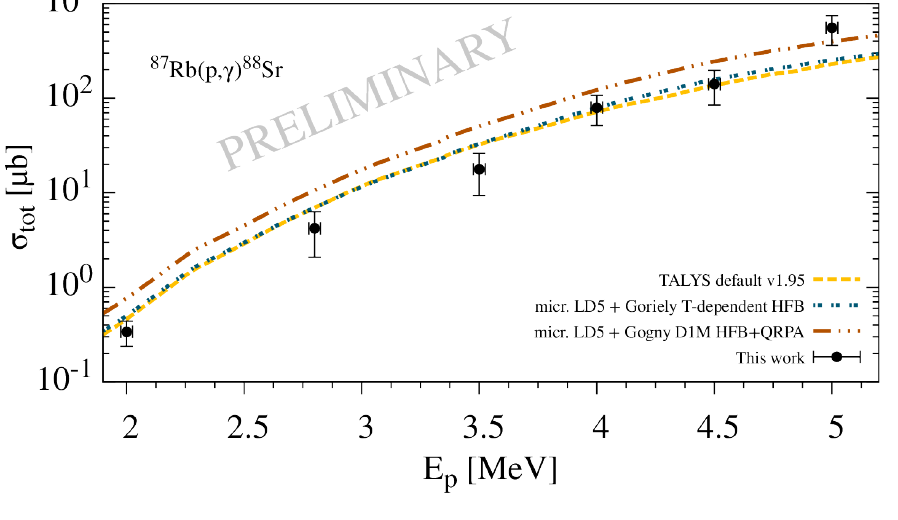
Figure 3. Experimental cross sections for the 87 Rb(p, γ ) 88 Sr reaction obtained in this work (black points). Statistical model calculations using the TALYS 1.95 code [6] are shown. The microscopic level density from Hilaire’s combinatorial tables [7] has been used in combination with the γ -ray strength function models Goriely T-dependent HFB [10] and Gogny D1M HFB + QPRA [11].